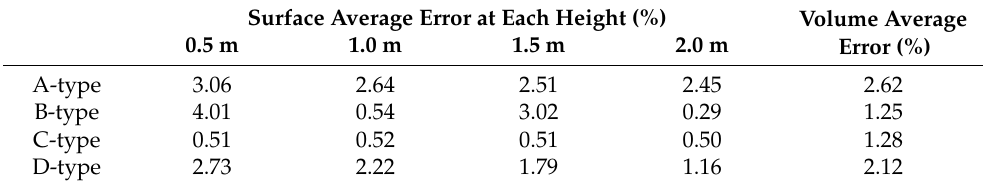
Table 7. Validation result for average